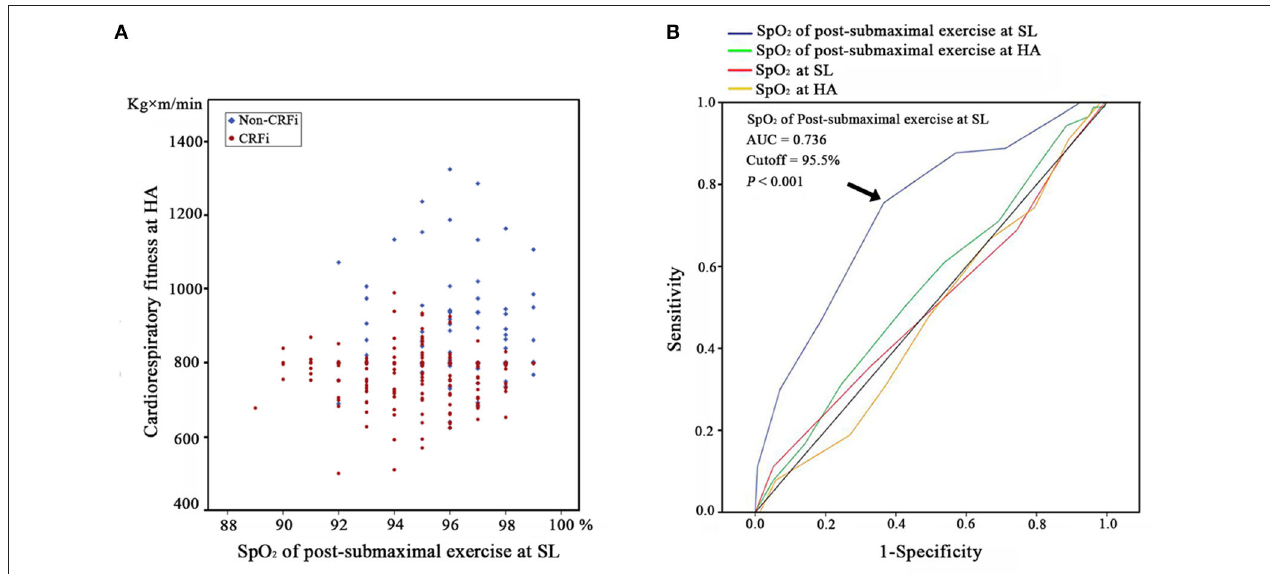
FIGURE 3 | Post-submaximal exercise SpO 2 at SL predicts the cardiorespiratory fitness at HA. (A) The distribution of HA cardiorespiratory fitness according to the different post-submaximal exercise SpO 2 measurements at SL. The red plots represent the subjects in the CRFi group, while blue plots represent the non-cardiorespiratory fitness impairment (CRFi) group. (B) ROC curves and AUCs for post-submaximal exercise SpO 2 at SL (blue line, AUC = 0.736, 95% CI = 0.6 72–0.801, p < 0.001), post-submaximal exercise SpO 2 at HA (green line, AUC = 0.547, 95% CI = 0.473–0.622, p = 0.217), SpO 2 at SL (red line, AUC = 0.505, 95% CI = 0.428–0.582, p = 0.897), and SpO 2 at HA (yellow line, AUC = 0.478, 95% CI = 0.403–0.552, p = 0.560) in the predictive models for CRFi. HA, high altitude; SpO 2 , oxygen saturation; SL, sea level; CRFi, cardiorespiratory fitness impairment; AUC, area under the curve; ROC, receiver operating characteristic.